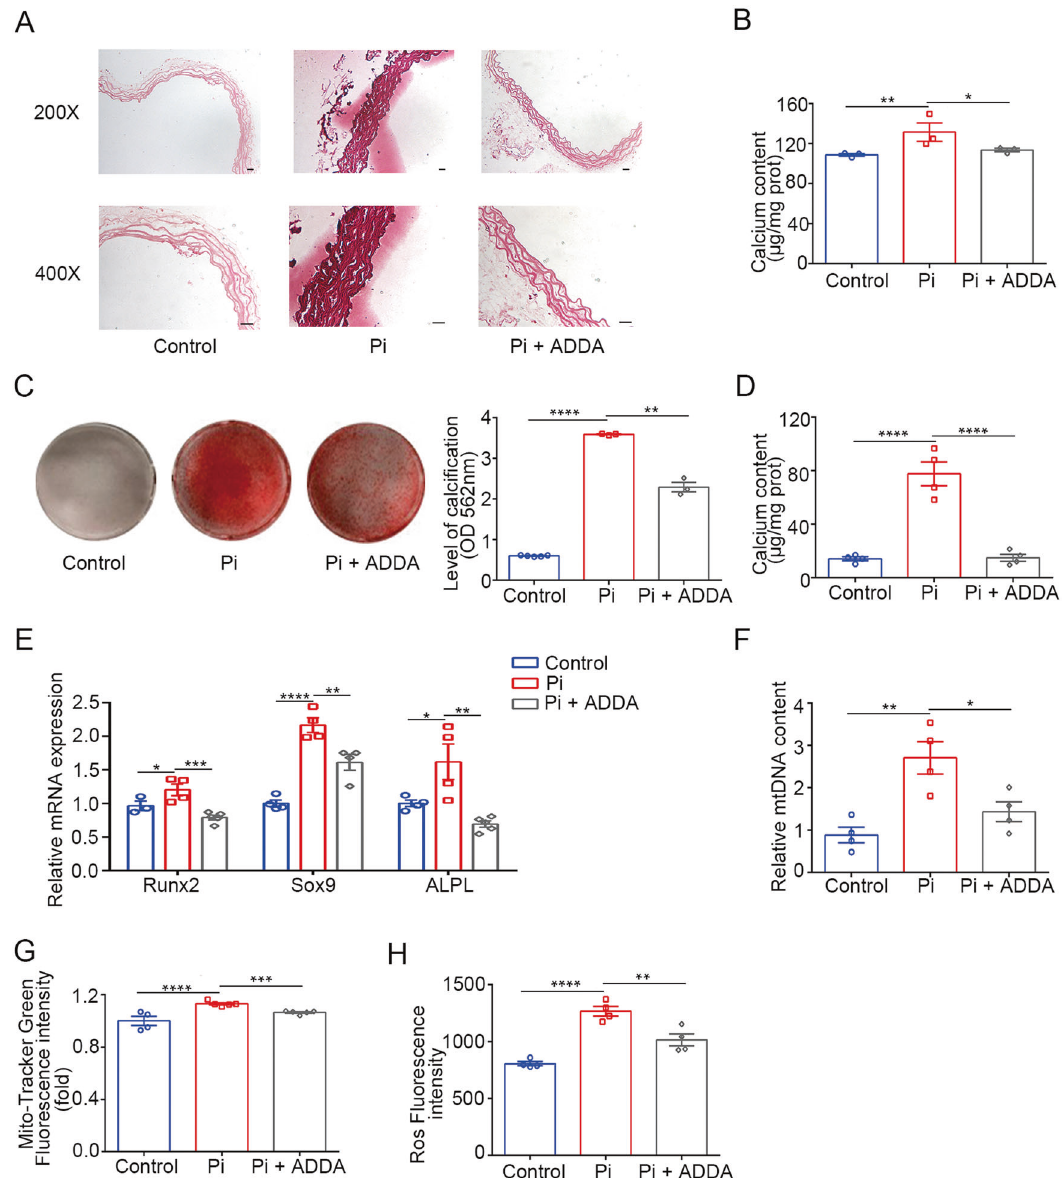
rings from mice. B Total calcium content in aortic rings (one-way ANOVA; n = 3). C Representative images and quanti fi cation of Alizarin red staining of HASMCs (one-way ANOVA; n = 3 – 5). D Total calcium content in HASMC (one-way ANOVA; n = 4). E Relative mRNA expression of Runx2, Sox9, ALPL in HASMC as detected by RT-qPCR (one-way ANOVA; n = 4). F Relative mtDNA content (unpaired t test; n = 4). G Measurement of the mitochondrial mass (one-way ANOVA; n = 4 – 5). H Measurement of the ROS level (one-way ANOVA; n = 4). * P < 0.05, ** P < 0.01, *** P < 0.001, **** P < 0.0001. Scale bar = 20